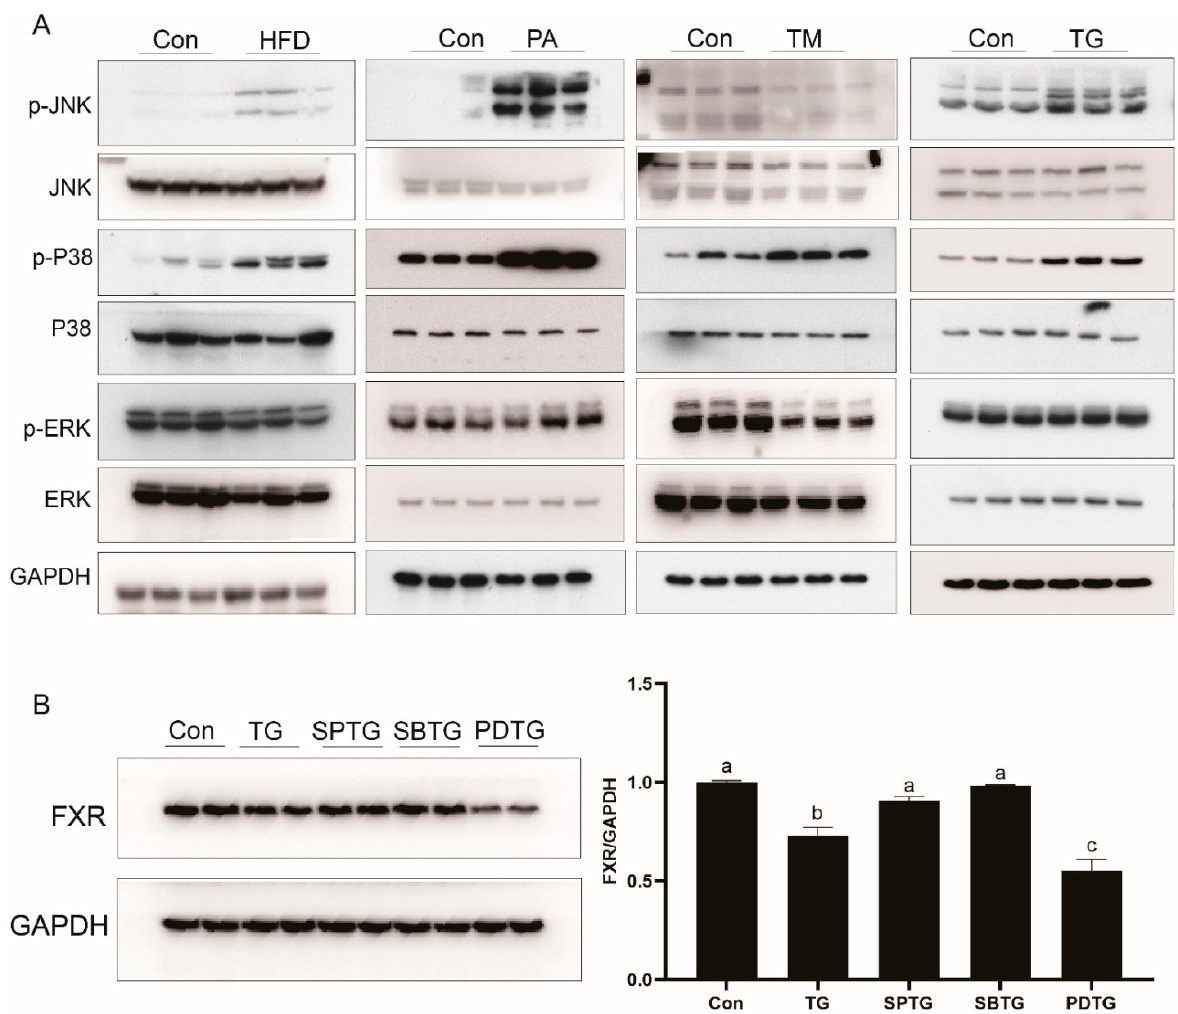
Figure 7. Effects of MAPK signaling pathway on the expression of FXR: ( A ) Immunoblots for MAPK signaling pathway in liver of large yellow croakers fed HFD diet and LYCL cells after PA, TM, or TG treatment; ( B ) immunoblots for FXR in LYCL cells after TG treatment alone or with MAPK inhibitors. Data are shown as means ± SEMs ( n = 3) and were analyzed using Duncan’s multiple range test and Student’s t -test. The letters a–c indicate that there is a significant difference between means, p < 0.05.